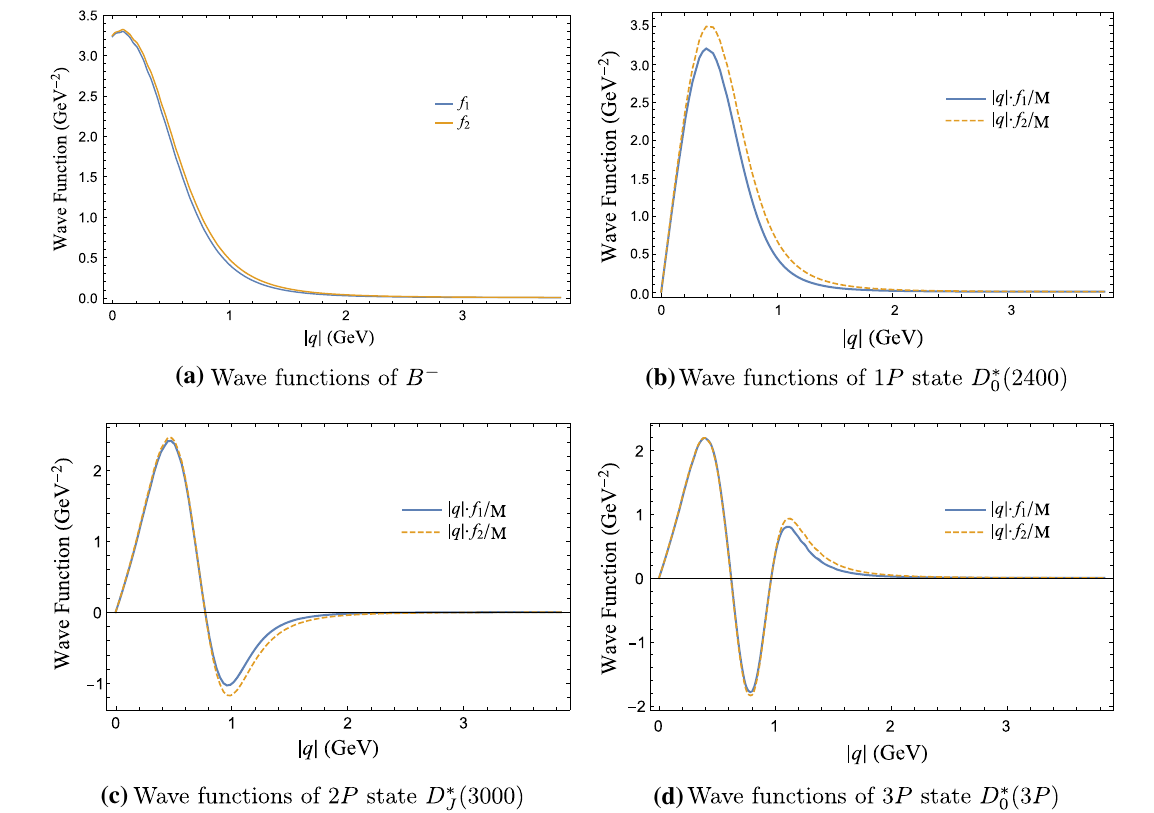
Fig. 4 Wave functions of B − and D ∗